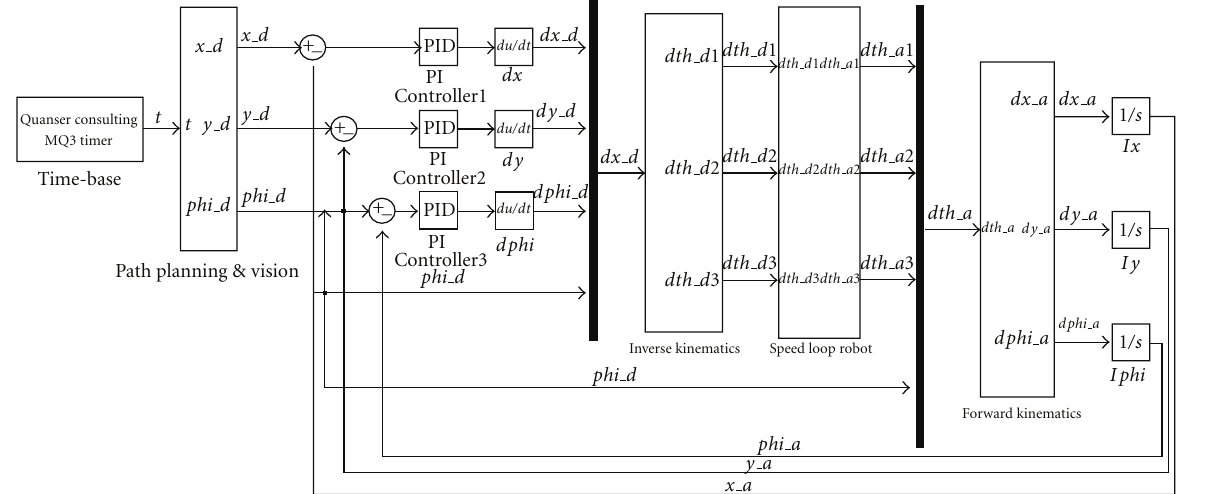
Figure 3: Two-level control architecture.